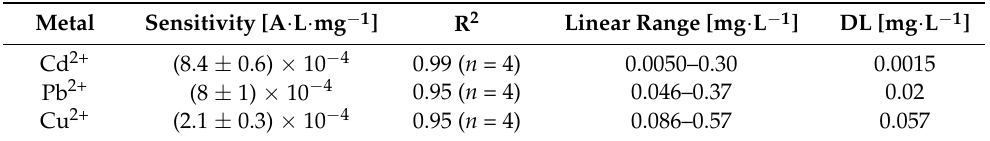
Table 2. The sensitivity, linear response range and DL of each metal cation simultaneously measured by SWASV with the Hg-NPs Route A